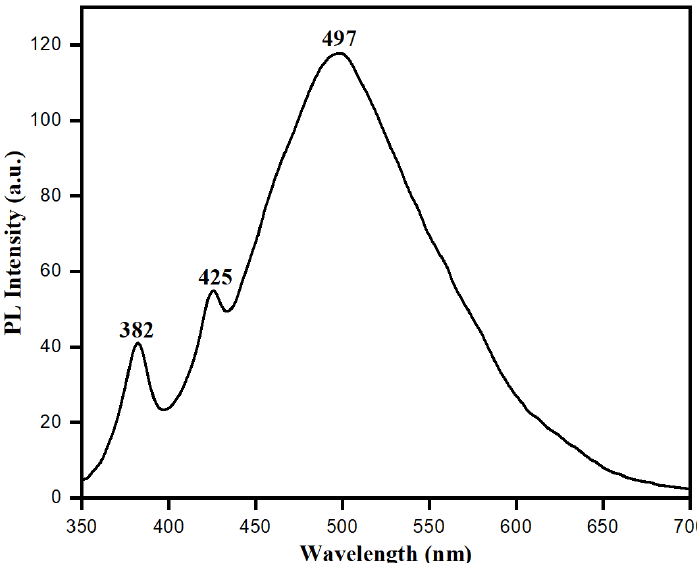
Figure 8. Photoluminescence spectra of bio ‐ fabricated ZnONPs.